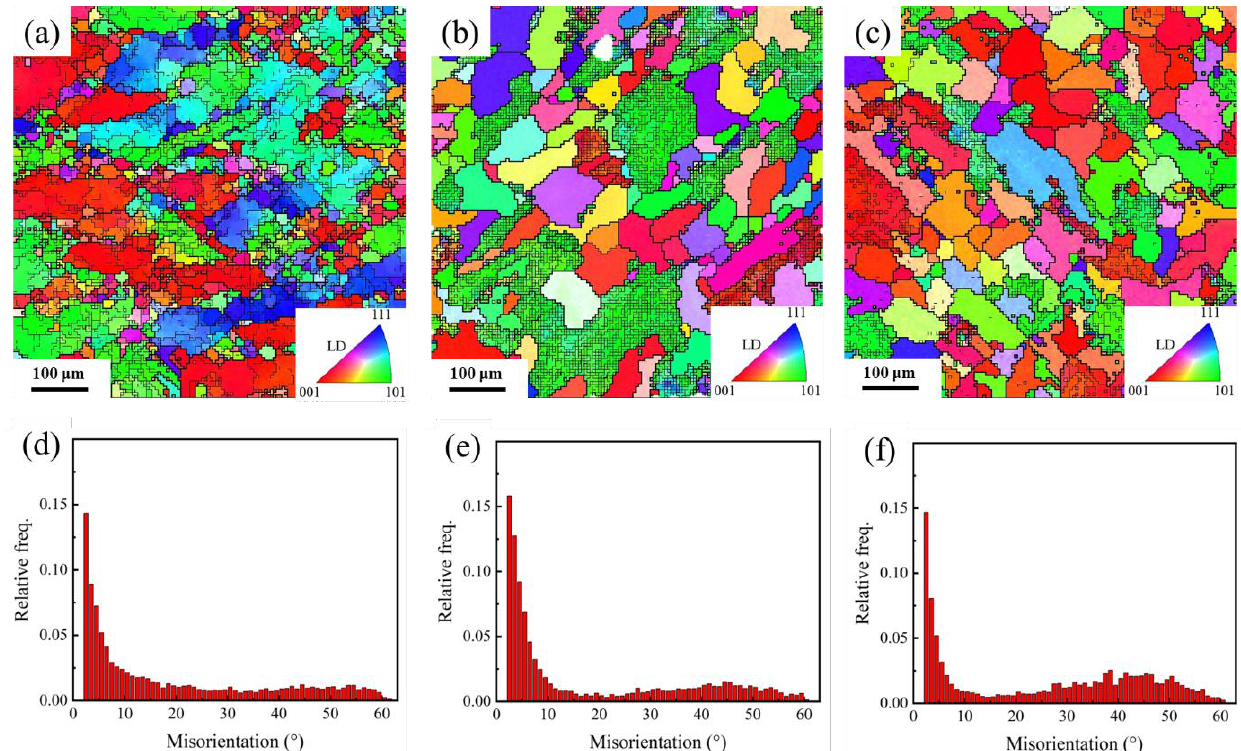
Figure 8. EBSD images and misorientation frequency of 7085 alloys after T6 heat treatment: ( a , d ) HTD; ( b , e ) MTD; ( c , f ) CTD.